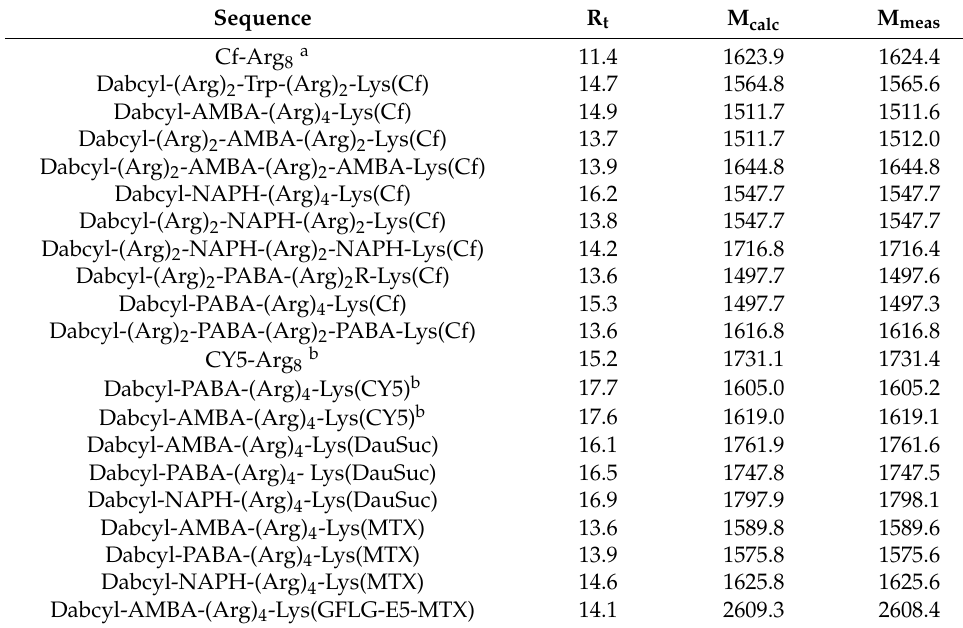
Table 1. Chemical characterization of peptide conjugates.